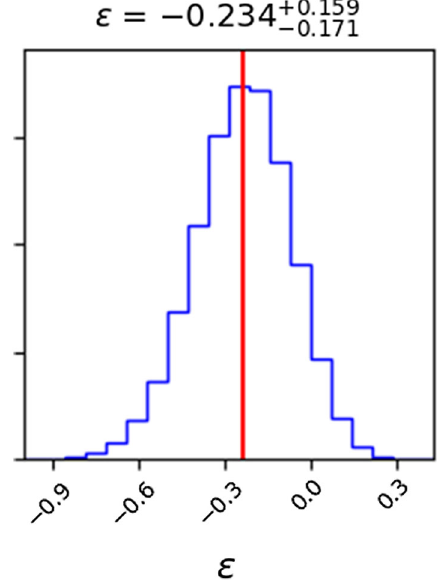
Fig. 2 The likelihood distribution for (cid:3) obtained after maximizing the likelihood in Eq. (9)